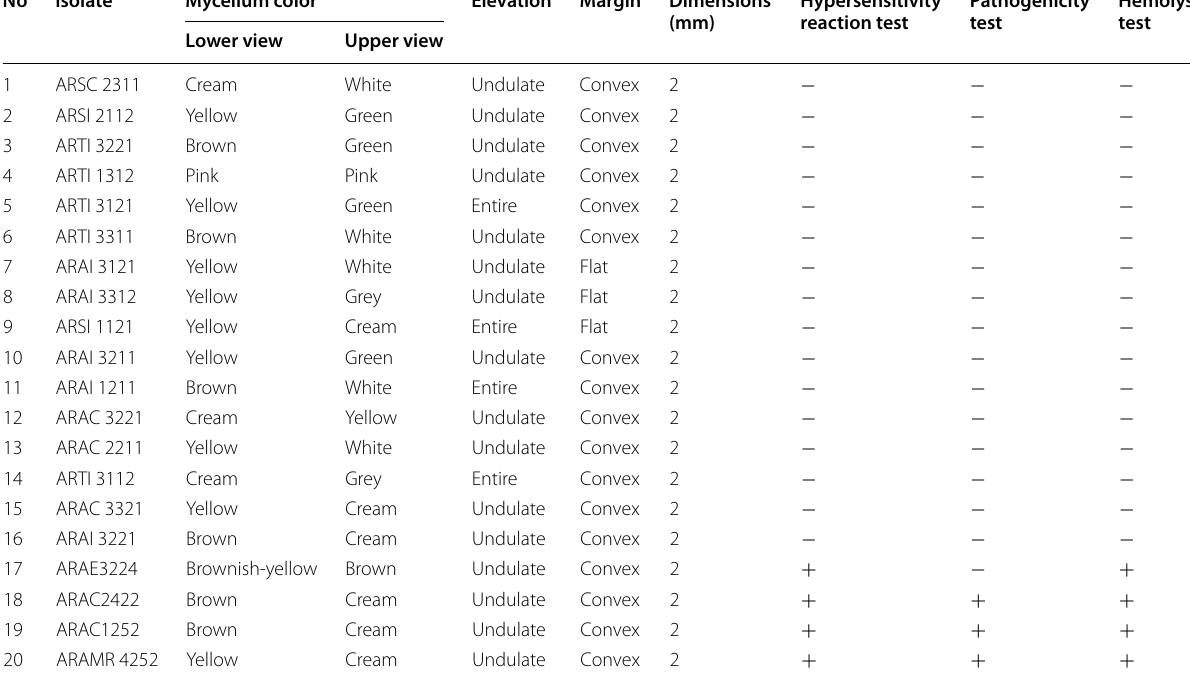
Table 1 Morphological diversity of actinobacteria isolates and their biosafety